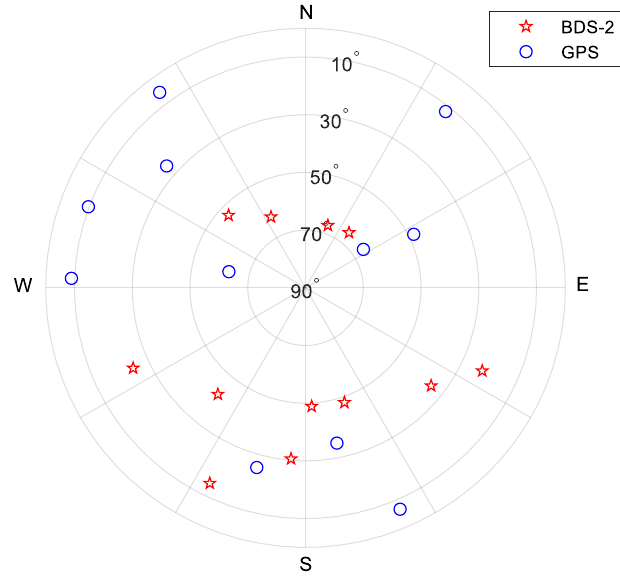
Figure 5. Sky plot view of the satellite geometry at the beginning of the trial.